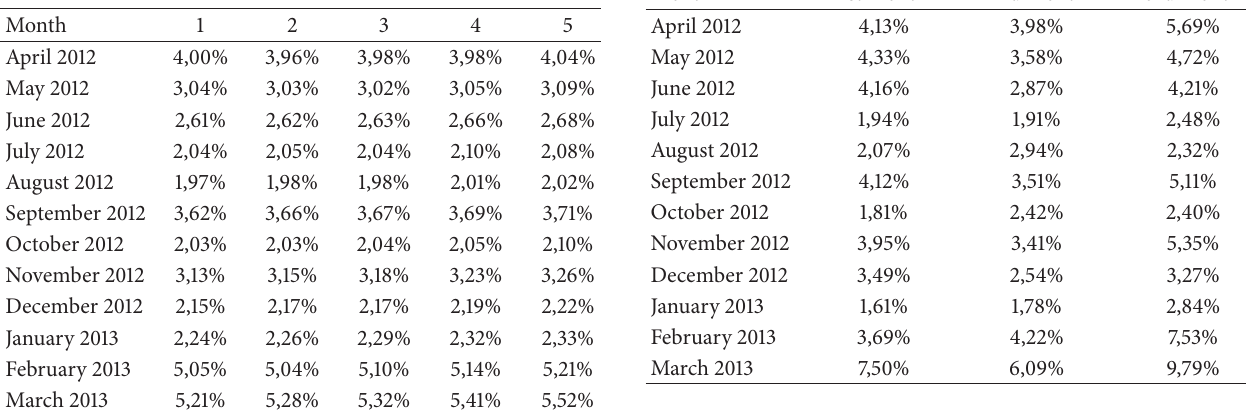
Table5:Inthefirstcolumn,wehavethemonthsofelectricitysupply of the peak contracts considered, while in the next five columns we have the mean absolute percentage errors (MAPE) obtained in the forecasts of the contracts value at 1, 2, 3, 4 , and 5 days ahead, respectively, using a geometric Brownian motion.